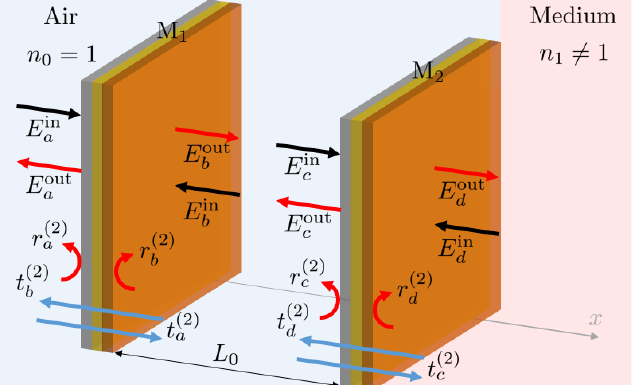
Figure 5. Schematic view of a Fabry-Pérot cavity, which consists of two mirrors, M1 and M2, with a distance L 0 between them. On its right-hand side, the cavity borders with a medium with a refractive index n 1 (cid:54) = 1. All other spaces are filled with air. As in Figure 4, the r and reflection rates, while the E in